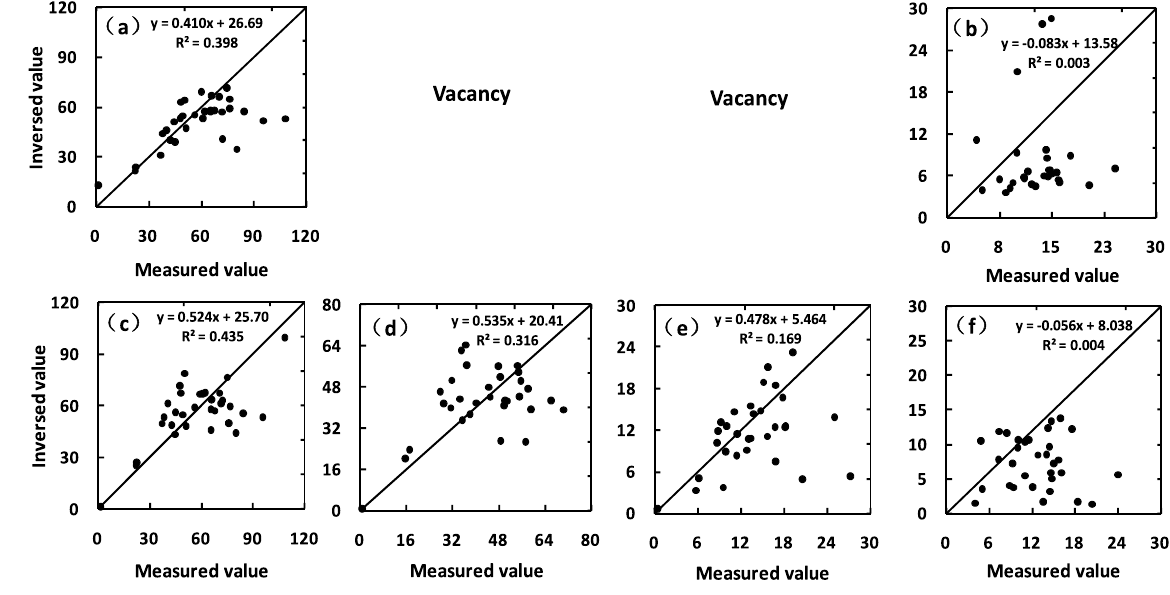
Figure 5. Comparison between measured and retrieved pigment concentrations ( µ g/cm 2 , n = 32). ( a ) and ( c ) are for Chls concentration; ( d ) is Chla; ( e ) is Chlb; and ( b ) and ( f ) are Cars; Retrievals ( a ) and ( b ) are from inversions of P5; ( c ), ( d ), ( e ) and ( f ) from PMP.